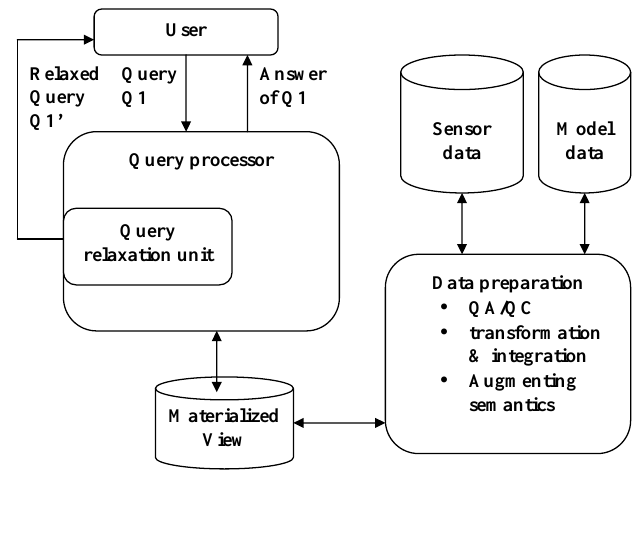
Figure 4. The steps in proposed smart query